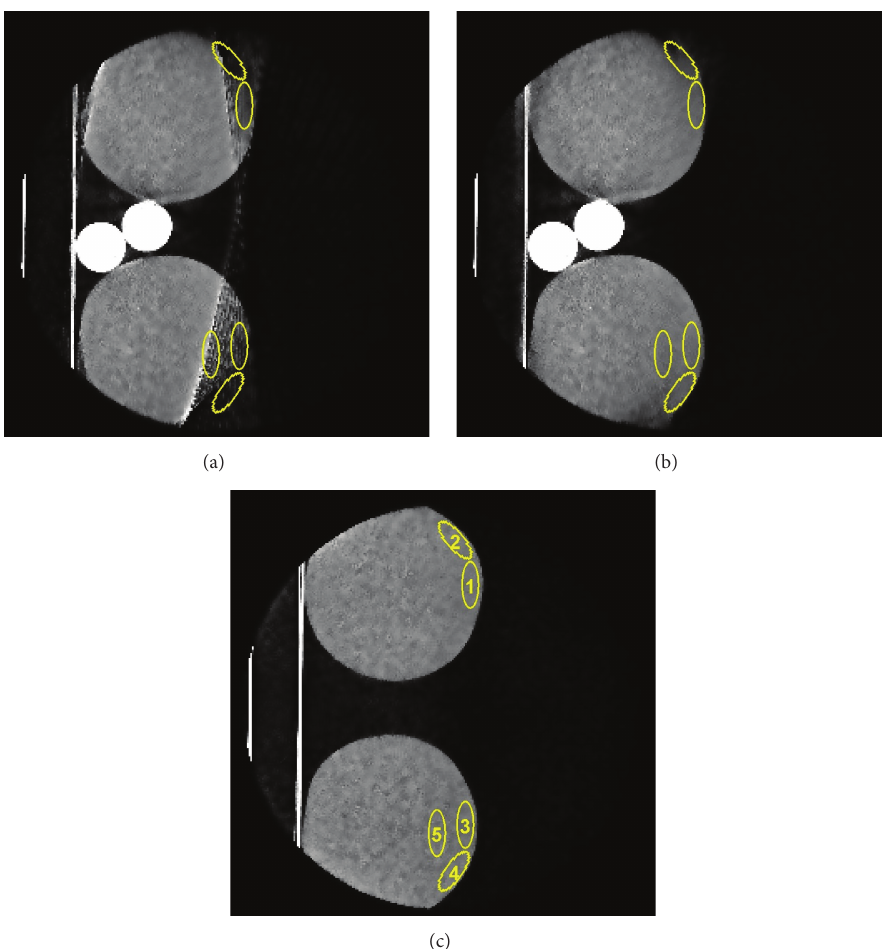
Figure 13: (a), (b), and (c) show 5 ROIs in the exterior regions of the bottles which are used for comparison reconstructed projections. The ROIs are evaluated for one slice in the uncorrected (a), corrected (b), and ground truth (c) data. Window level: [ − 1000,